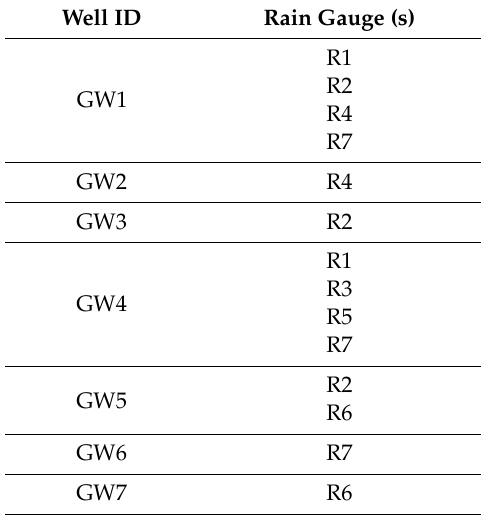
Table 2. Rain gauges associated with each well based on geographic proximity.